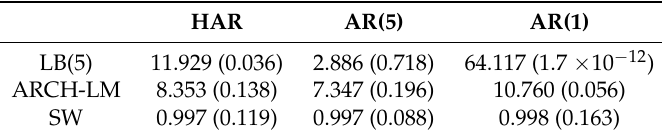
Figure 8. (cid:98) w t , in-sample autocorrelations of AR(1) residuals ( left ) and their squares ( right ). Table 6. (cid:98) w t , in-sample residual diagnostic test